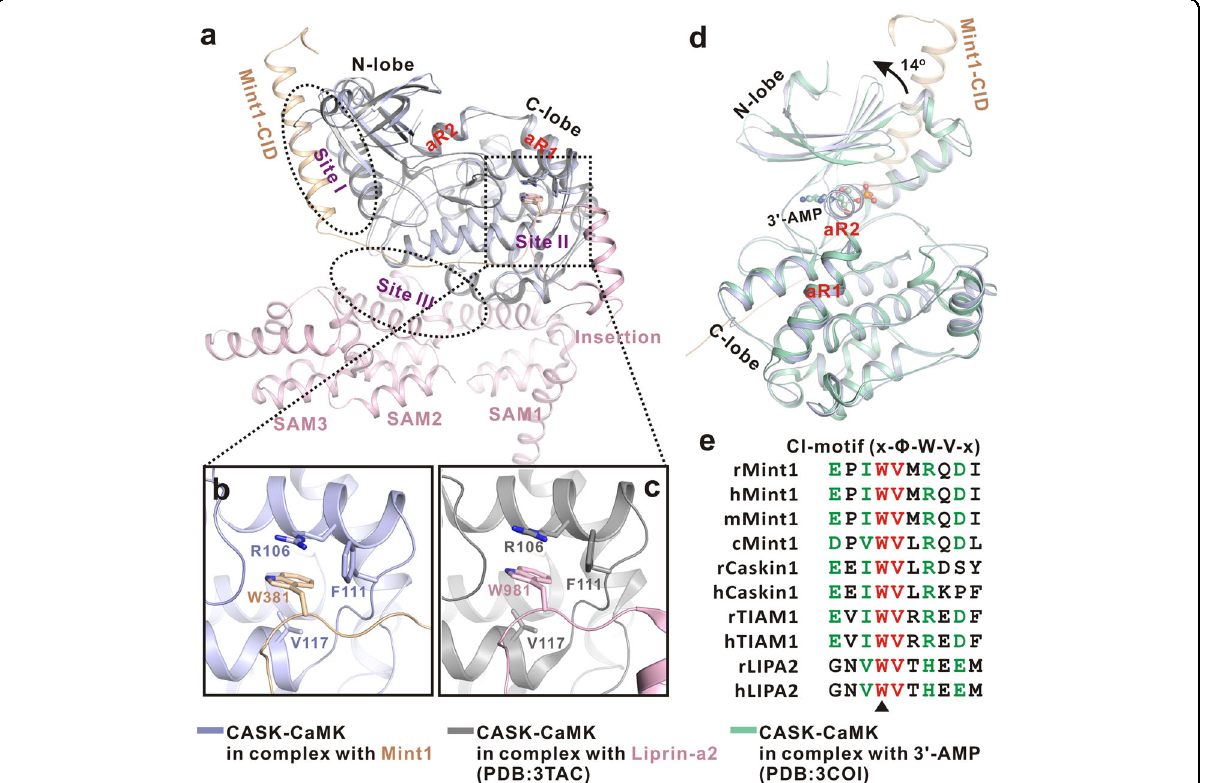
Fig. 8 Structural comparison of CASK/Mint1 complex and other CASK complexes. a Overall structural comparison of CASK/Mint1 complex and CASK/Liprin- α 2 complex. In the comparison, CASK-CaMK in the complex with Liprin- α 2 is colored in dark gray and Liprin- α 2 is colored in pink. b , c Similar Trp-binding pocket of CASK-CaMK in complex with Mint1 ( b ) and Liprin- α 2 ( c ). d Structural comparison of CASK/Mint1 complex and AMP- bound CASK-CaMK. In the comparison, AMP-bound CASK-CaMK is colored in cyan with AMP-molecule shown as spheres. And ~14° orientation difference in their N-lobes of the two structures is indicated by an arrow. e Sequence alignment of the conserved “ Trp ” -containing CI-motifs from Mint1 and other CASK-binding